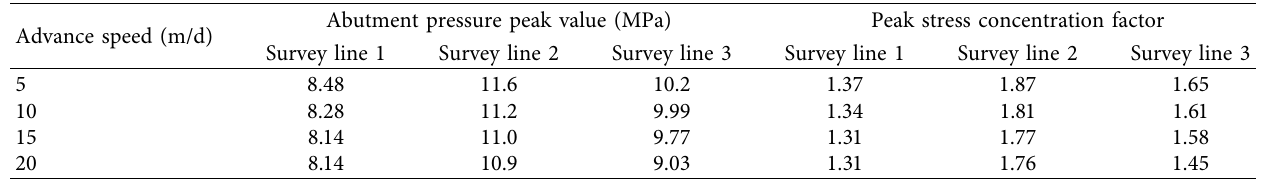
Figure 5: Distribution of advance bearing pressure of the working face under different rates of advance. Advance speed of (a) 5m/d, (b) 10 m/d, (c) 15m/d, and (d) 20m/d. Table 5: Roof pressure characteristics at different rates of